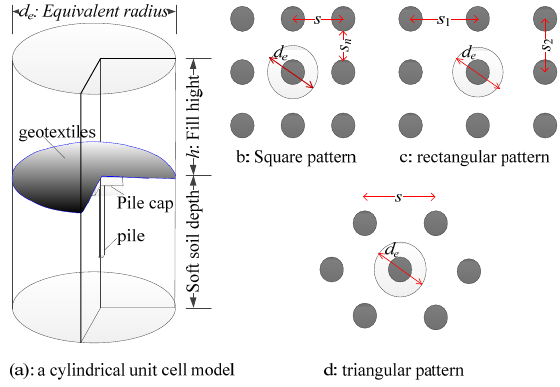
Figure 2. The installation pattern of piles: ( a ) a cylindrical unit cell model, ( b ) square pattern, ( c ) rectangular pattern, ( d ) triangular pattern.